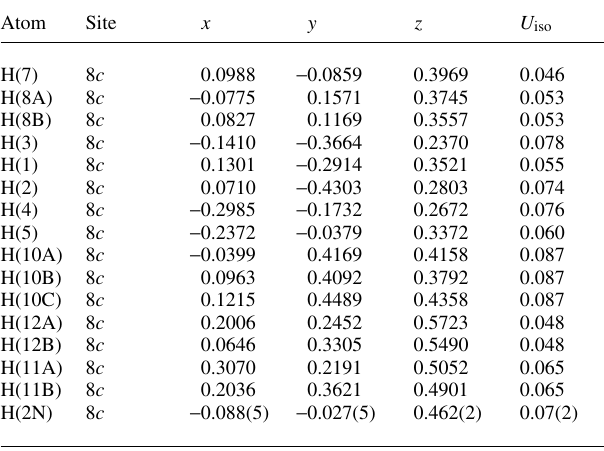
Table 2. Atomic coordinates and displacement parameters (in Å 2 )